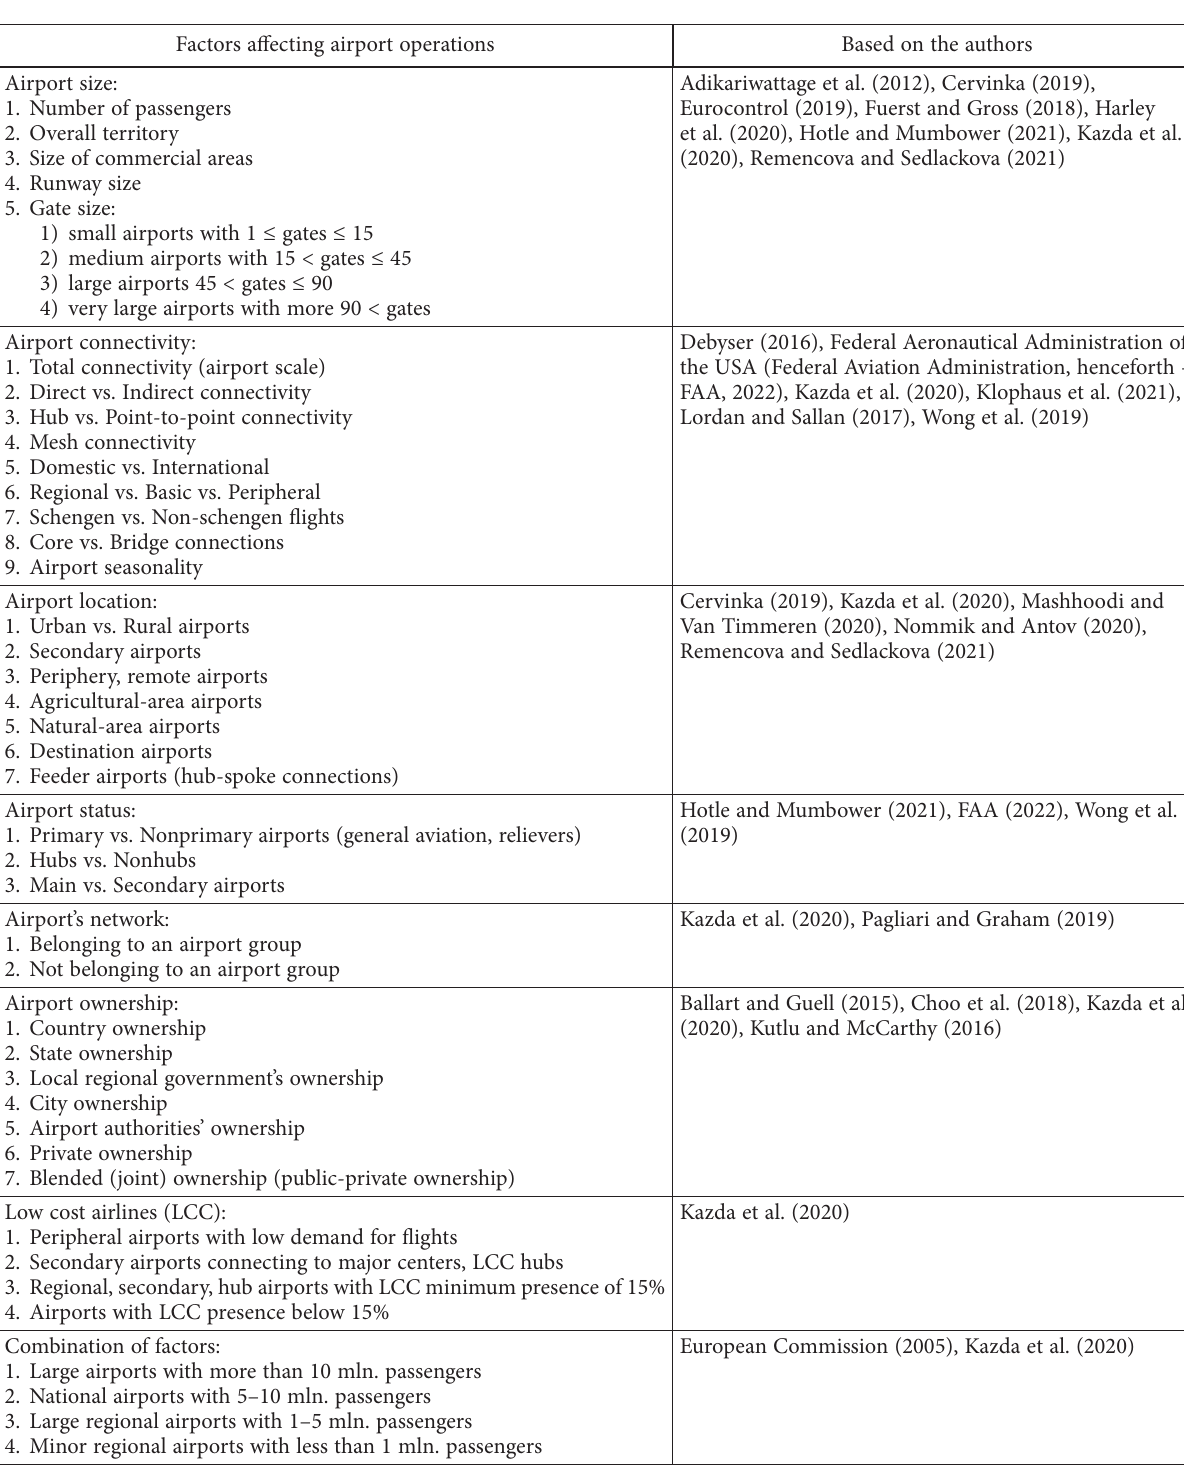
Table 1. Factors affecting airport performance, connectivity and capacity (created by the authors) Factors affecting airport